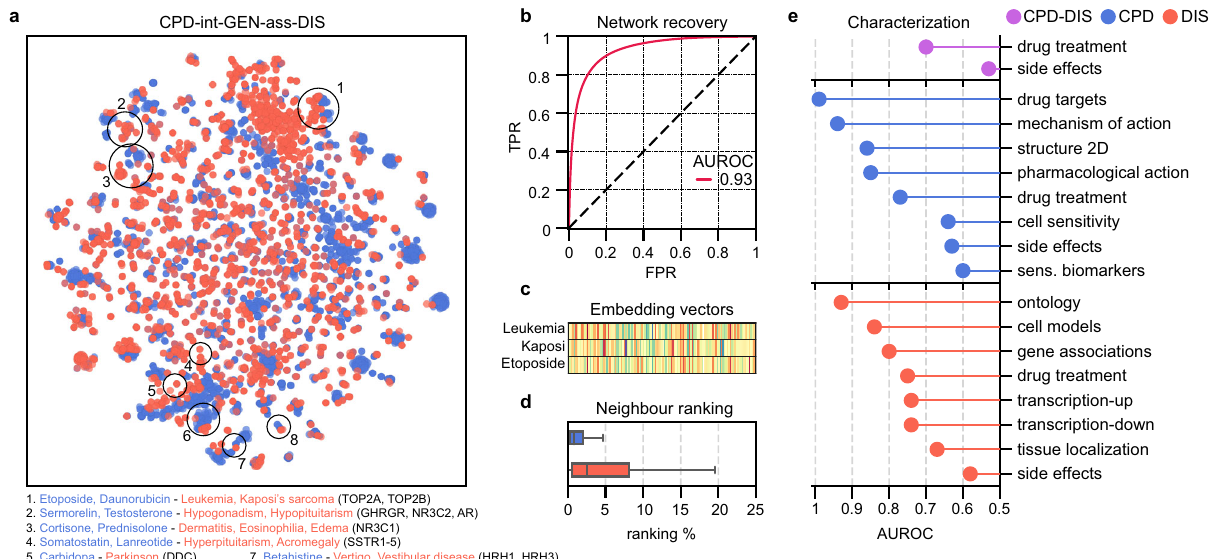
Fig. 3 | A Bioteque embedding summary card. a 2D projection (opt-SNE) of the compound (CPD, blue) and disease (DIS, red) embeddings from the metapath ‘ compound interacts protein associates with disease ’ (CPD-int-GEN-ass-DIS). We highlight clusters of compounds and diseases sharing treatment evidence. We highlight some representative compounds and diseases found in these clusters, togetherwiththedrugtargetsassociatedwiththediseases. b ROCcurvevalidation when reconstructing the original network with the corresponding embeddings. c Visual representation of the embedding vectors of leukaemia (top) and Kaposi ’ s